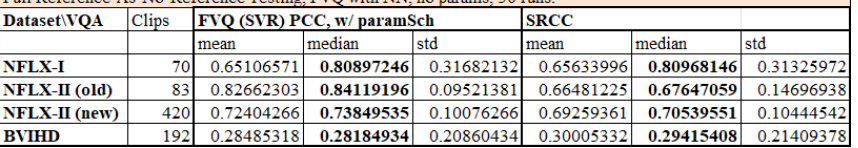
Figure 3. Simulations in the full reference databases, but ignoring the reference videos (full-as-no-ref). It is encouraging to see that even by working without the reference, but otherwise using the same framework (including the same feature types and regressor engines), we were able to obtain quite useful results. This partly validates our attempts at a unified framework for VQA. We remark that this approach may be applied even if the reference is not at hand, and can simplify the workflow more generally. We note that this application is still in the context of the high-quality FR data. By contrast, it is much more difficult to obtain good performance in the true no reference case.